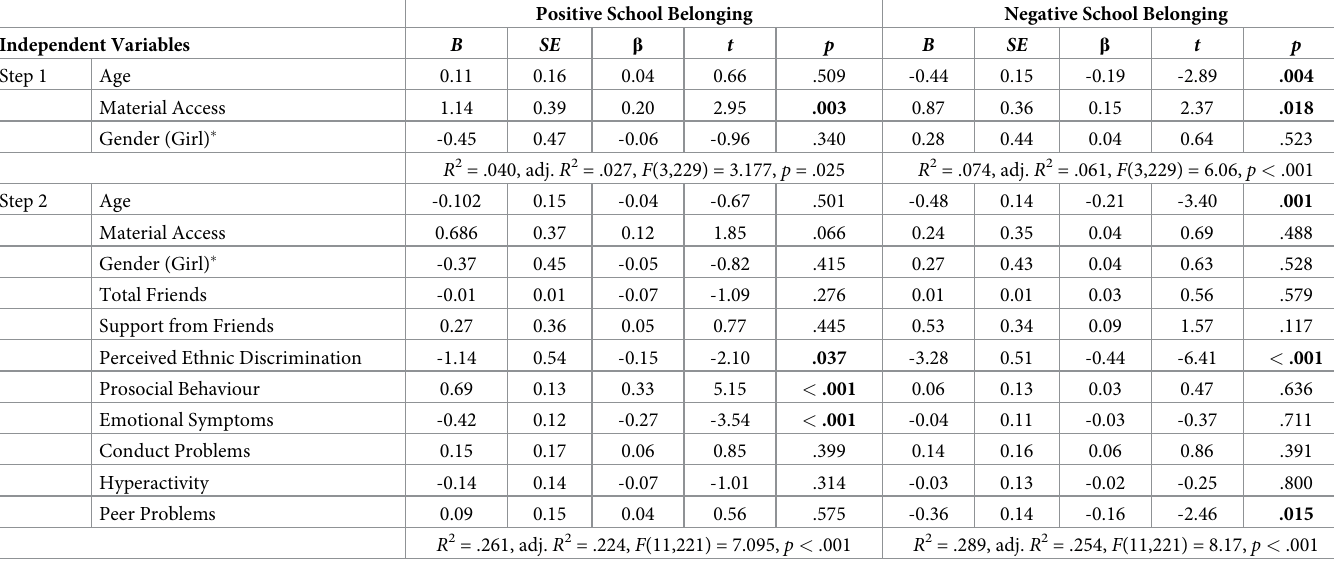
Table 4. Summary of multivariate regression models for correlates with positive and negative school